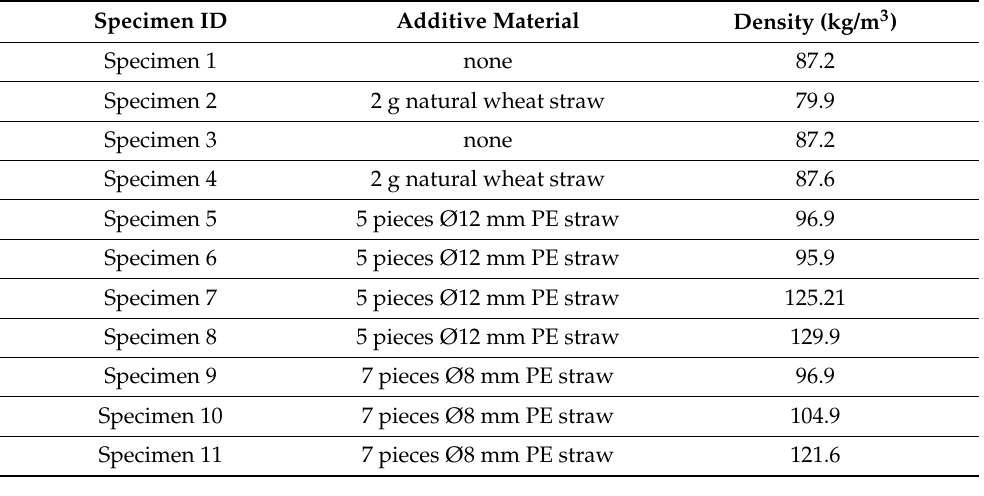
Table 3. Properties of the measured specimens.